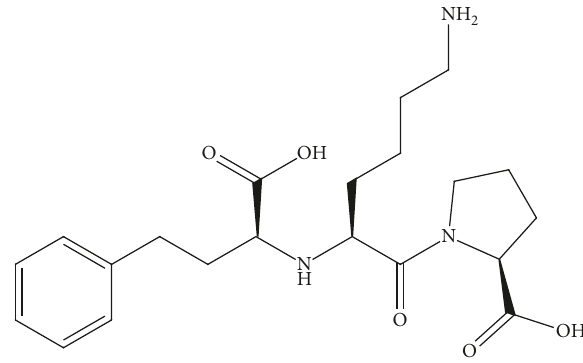
Figure 1: Molecular structure of the